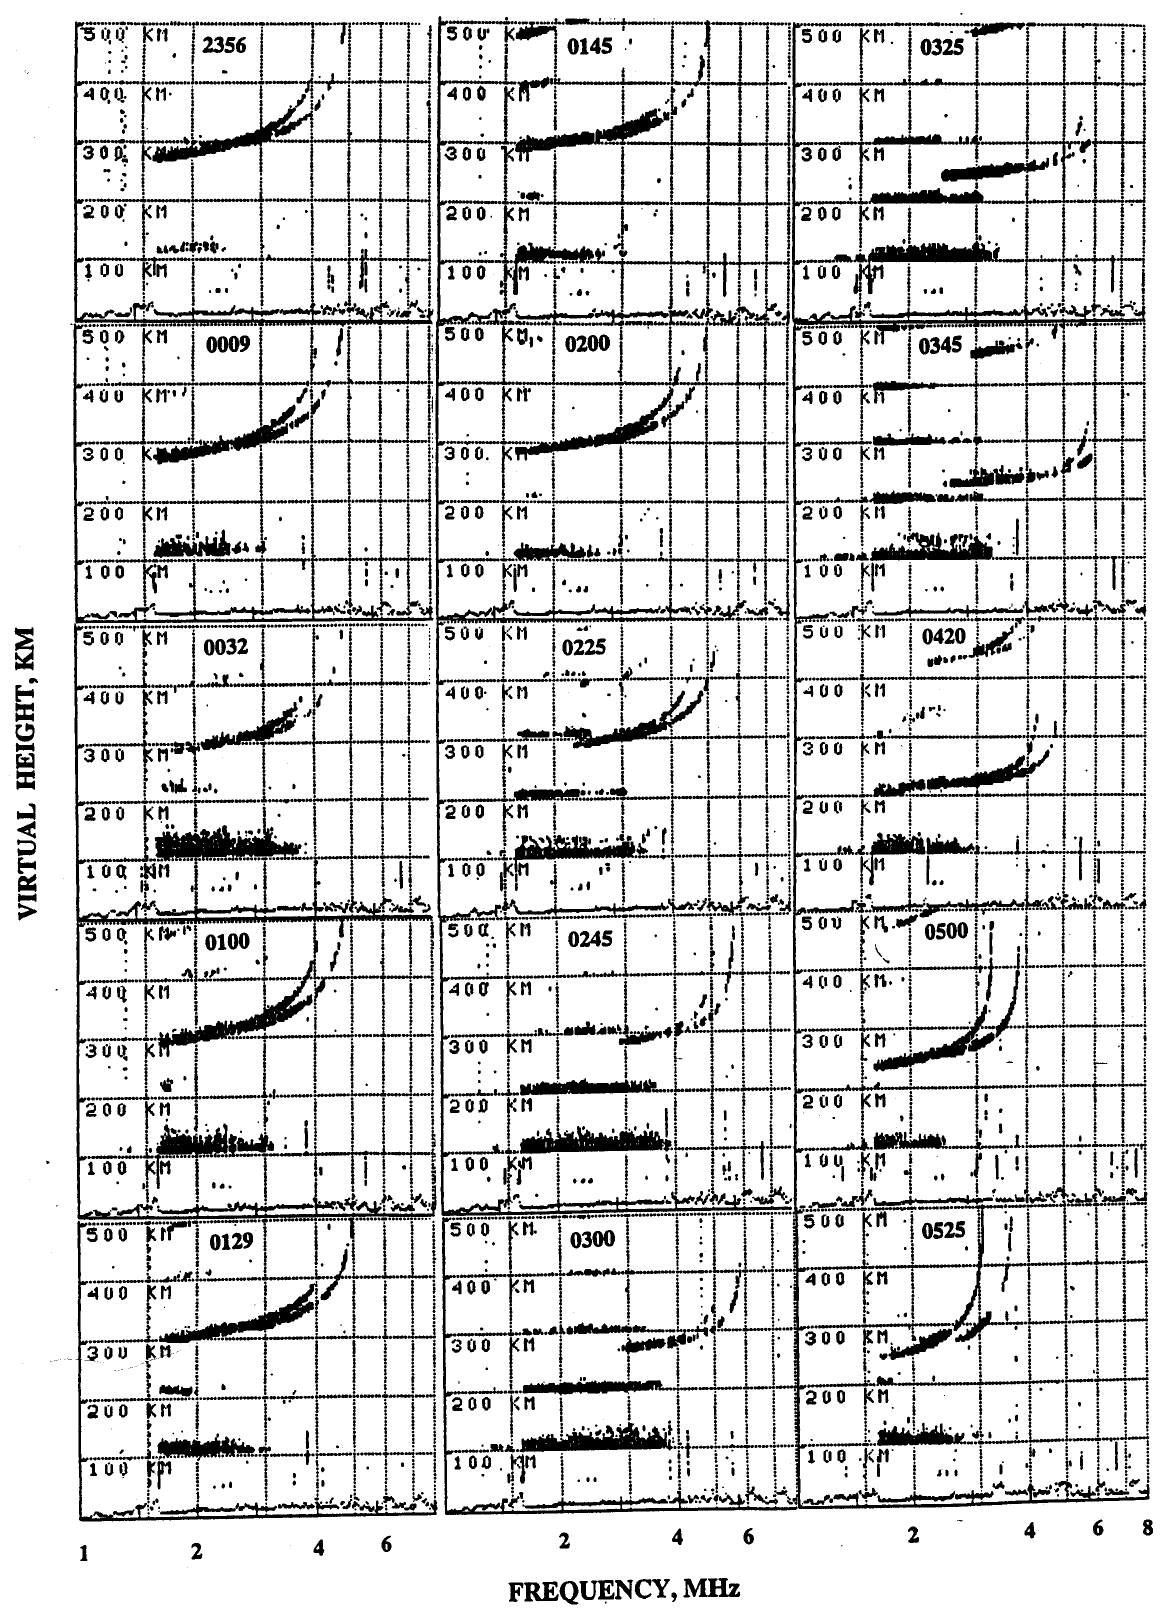
Fig. 6. Selected ionograms over Ahmedabad during the night 17–18 November 1998 showing the development of sporadic-E associated with Leonid shower